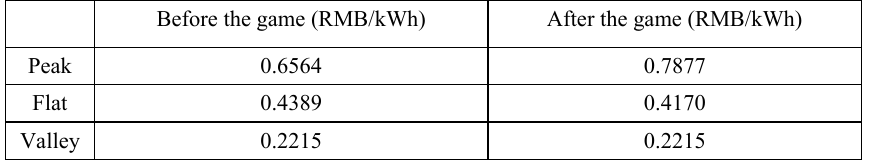
Table 1. Comparison of electricity price in peak and valley period before and after game. Before the game (RMB/kWh) After the game (RMB/kWh)